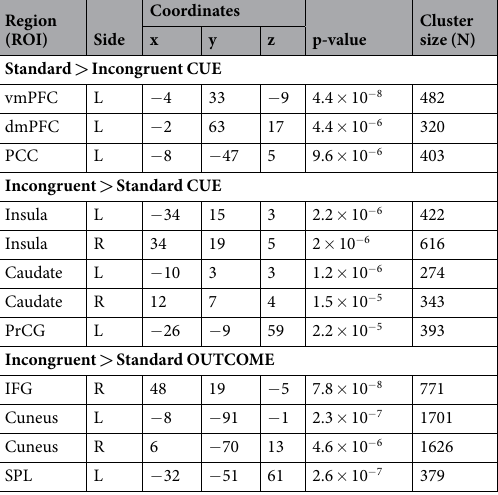
Table 1. List of brain regions showing significant differential activation in response to standard vs. incongruent cues and outcomes. Cluster size indicates the number of voxels surviving Monte Carlo corrected threshold. Coordinates and the p value are shown for the peak voxel in each region. Abbreviations: dmPFC: dorsomedial prefrontal cortex, IFG: inferior frontal gyrus, PCC: posterior cingulate cortex, PrCG: precentral gyrus, SPL: superior parietal lobule, vmPFC: ventral medial prefrontal cortex.